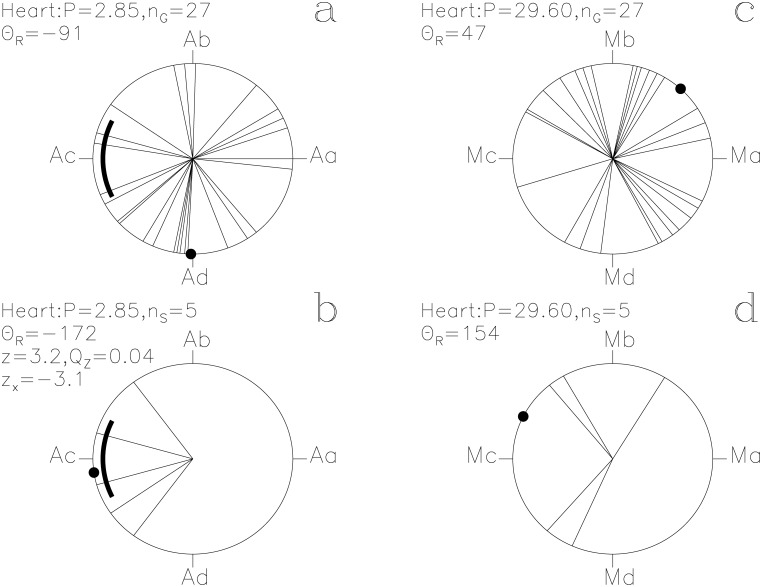
Heart.otherwise as in Fig 1